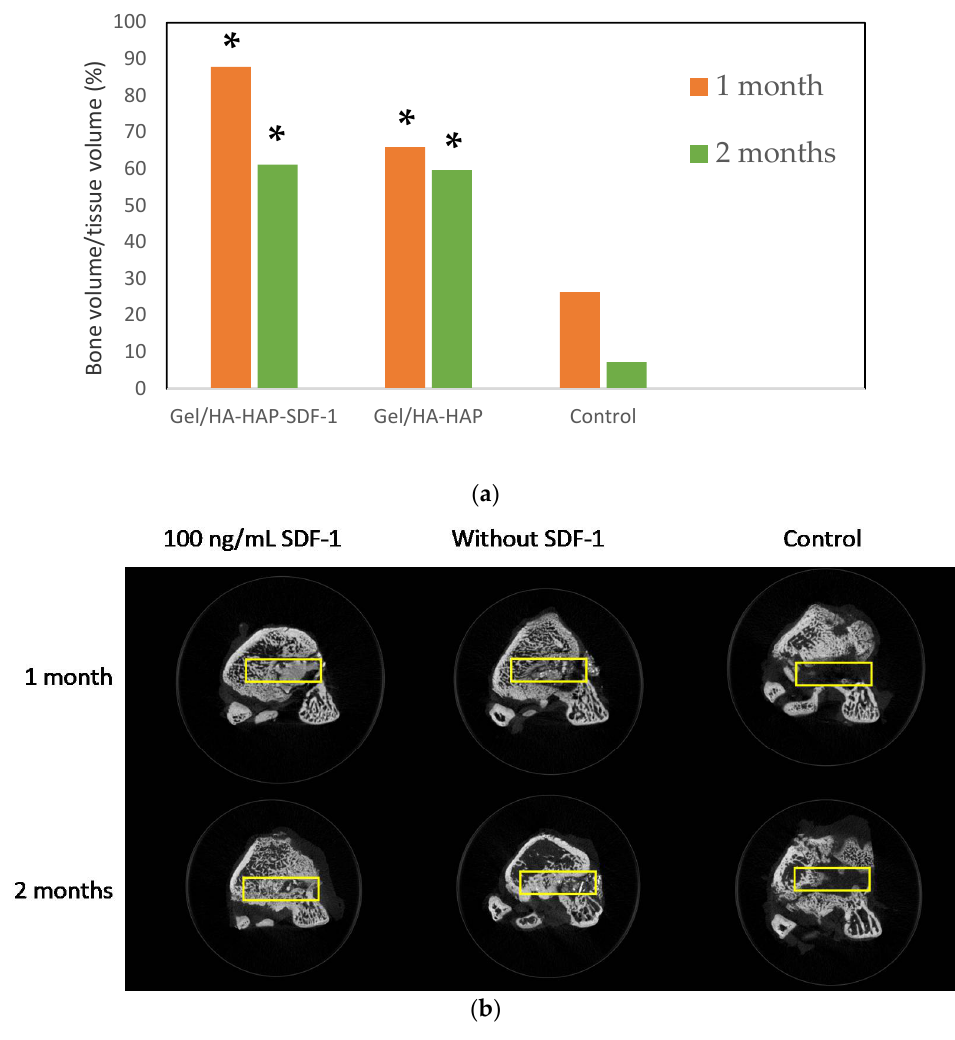
Figure 9. Micro-CT analysis and imaging. ( a ) Bone volume (BV)/tissue volume (TV) analysis over the bone defect sites of the scanned rat femur ( n = 3). Compared with the control group, there was more new bone formation in both composite groups. * p < 0.001 ( b ) Micro-CT sections of femur specimens one month and two months after surgery. The bone defect sites are indicated with yellow rectangles.